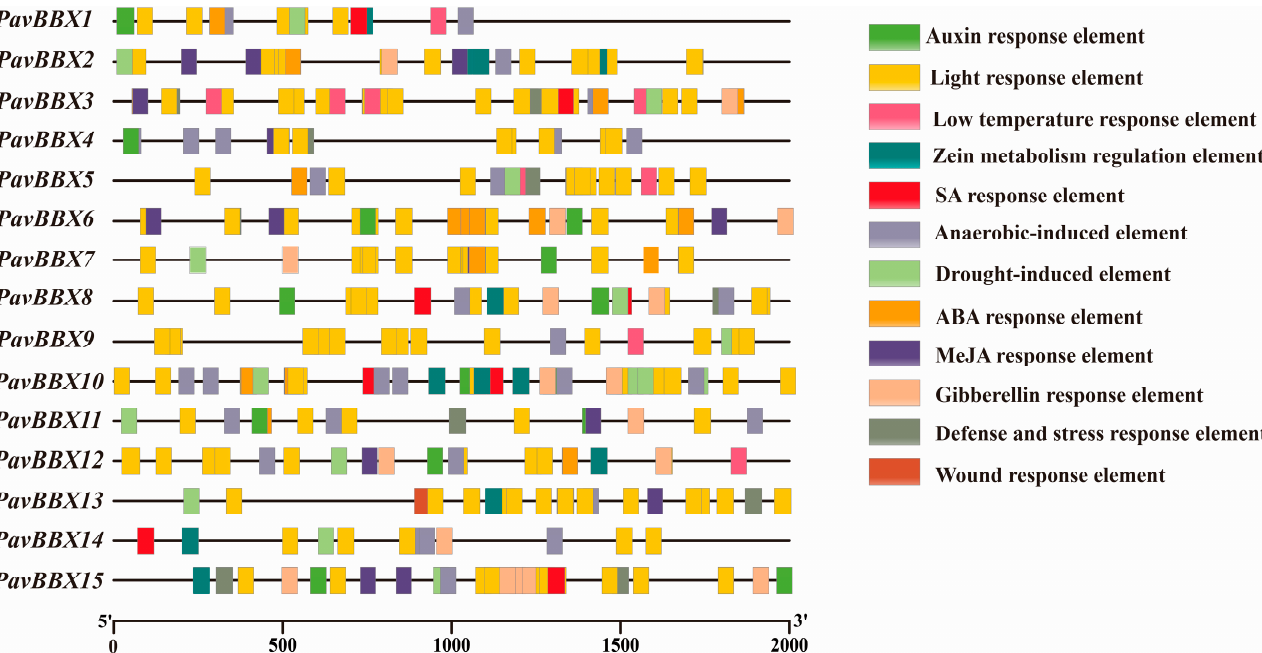
Figure 3. Schematic representation of the predicted regulatory cis -elements in the promoters of PavBBX family genes. The scale bar represents base pair.